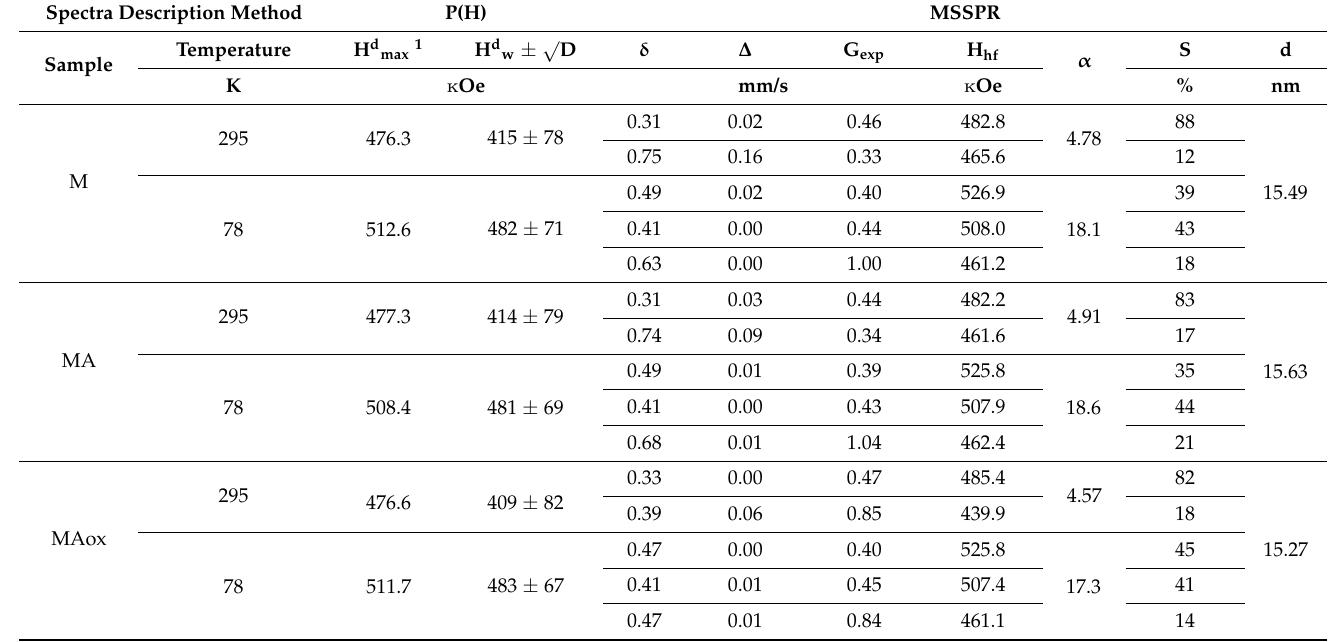
Table 3. Results of the description of the Mössbauer spectra of the samples Fe 3 − δ O 4 using the distribu- tion function of magnetic fields (P(H)) and within the framework of the multilevel superparamagnetic relaxation (MSSPR) model.